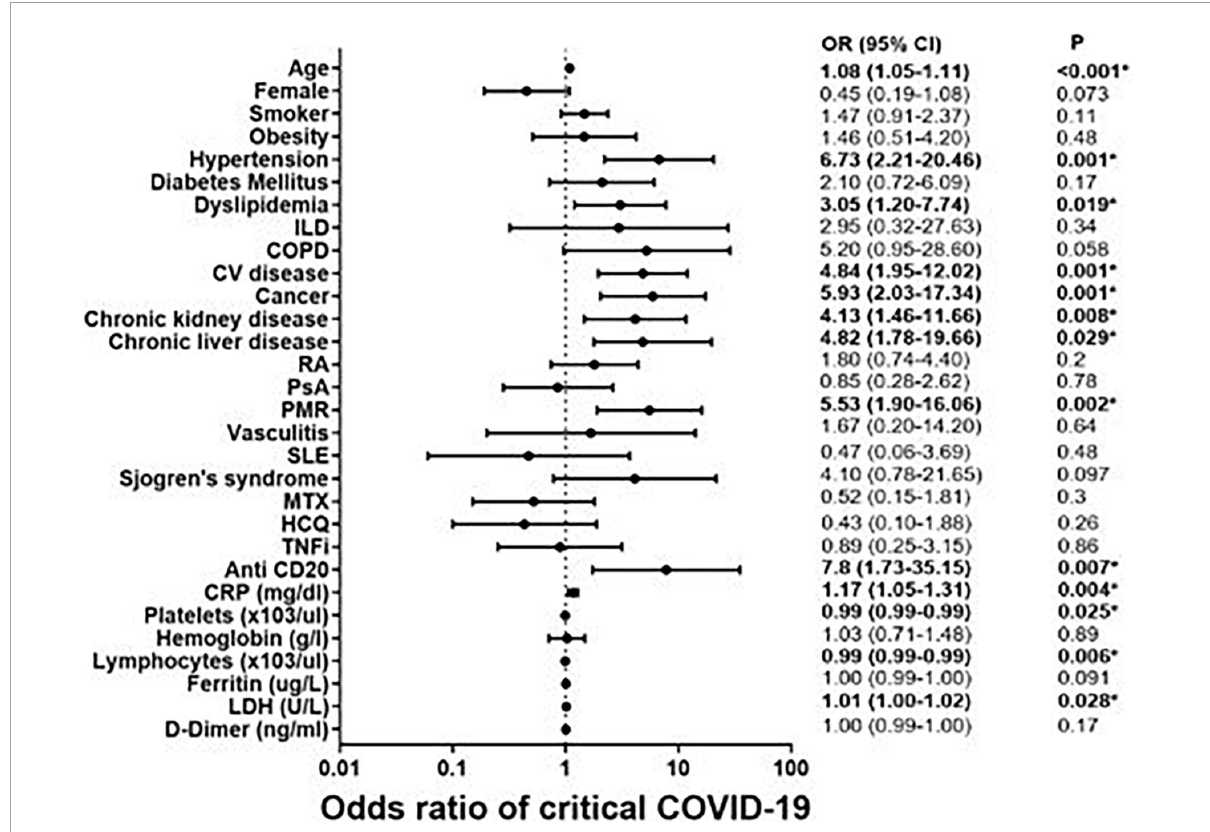
FIGURE1 Predictive severity coronavirus disease 2019 (COVID-19) factors in 274 patients with rheumatic immune-mediated diseases